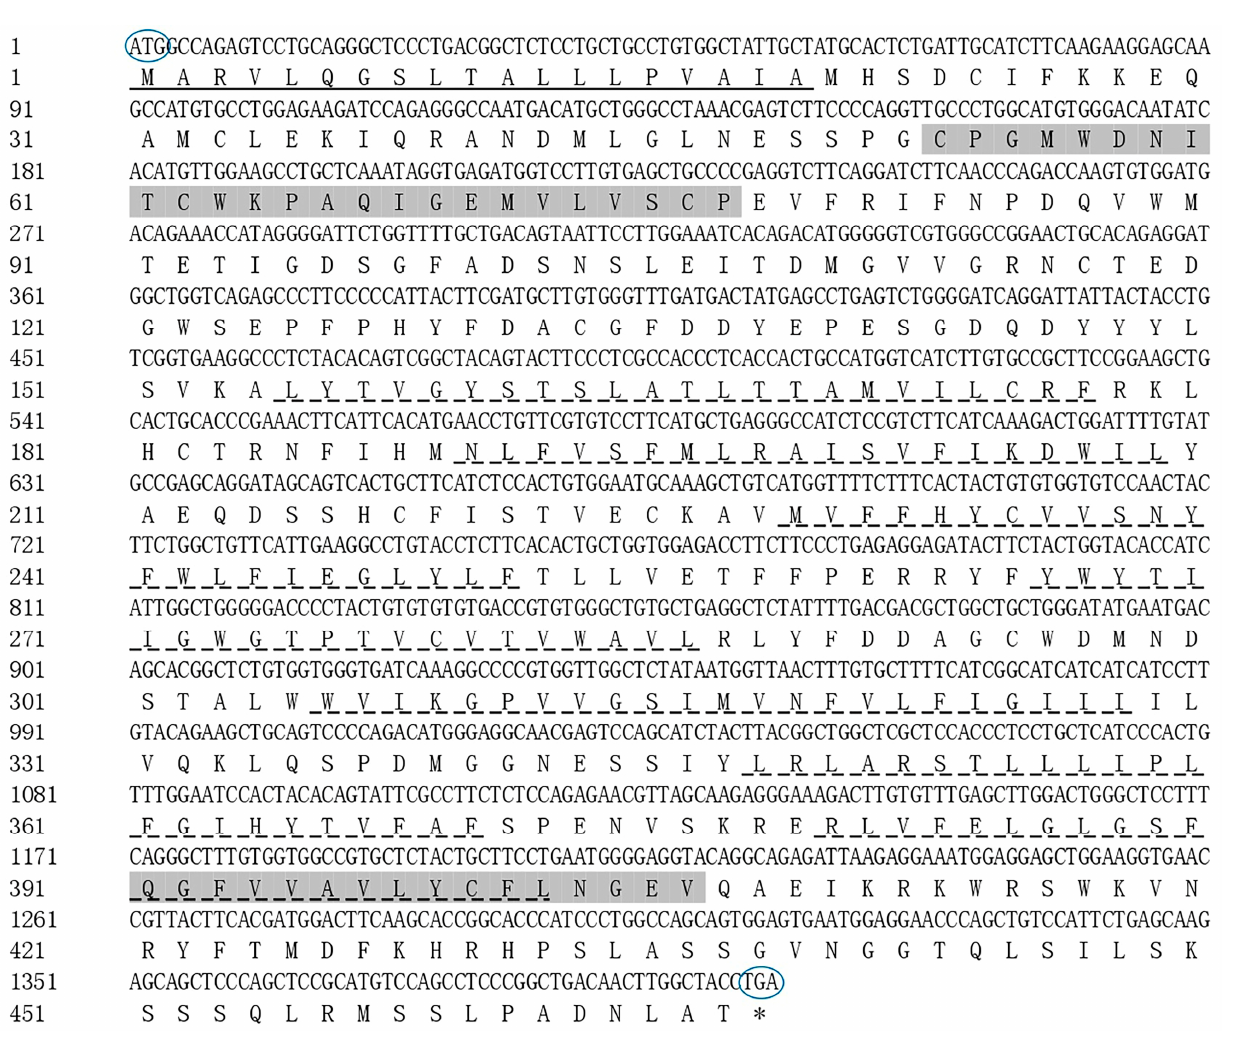
Figure 3. Nucleotide sequence and derived amino acid sequence of coding region of PAC1R : The number of nucleotides and derived amino acid residues are shown on the left. Oval indicates start and stop codons. Underlined are the signal peptides. The dotted line marks 7 transmembrane regions and the G protein-coupled receptor family tag in the shaded portion. * indicates that the stop codon (TGA)does not encode amino acids.